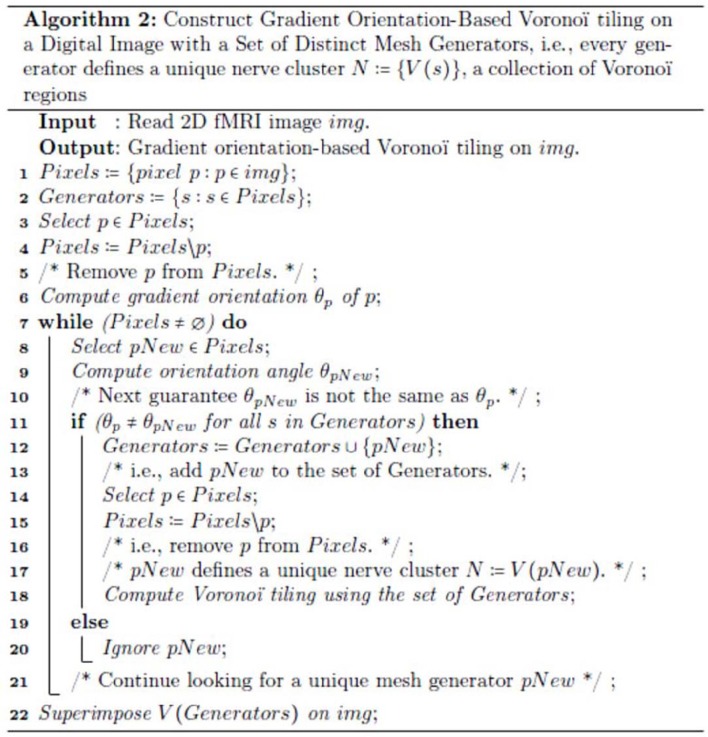
The steps in the method used to construct the mesh on an fMRI image shown in Figure 1D.